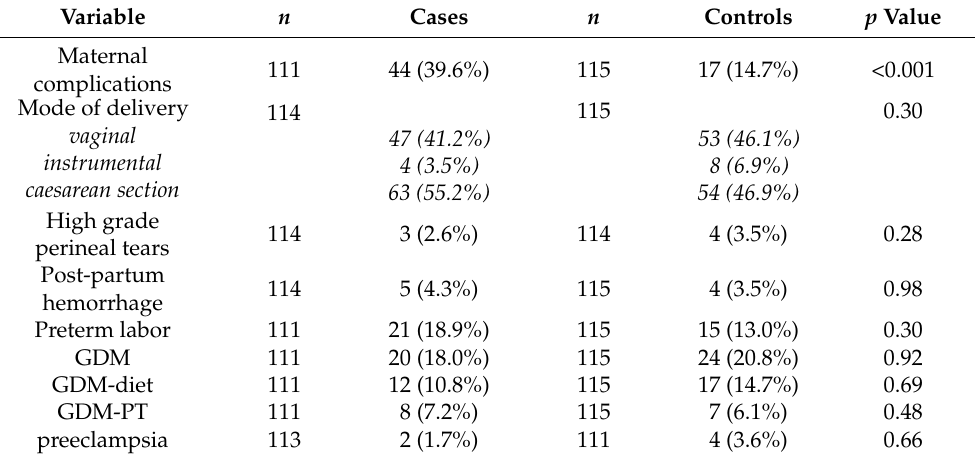
Table 2. Maternal outcomes of the 230 study participants with and without beta-thalassemia